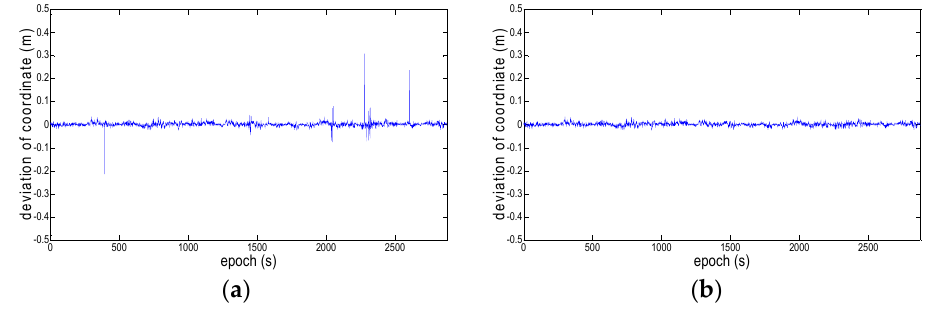
Figure 6. Deviation of coordinate (East). ( a ) without robust estimation; ( b ) with robust estimation.